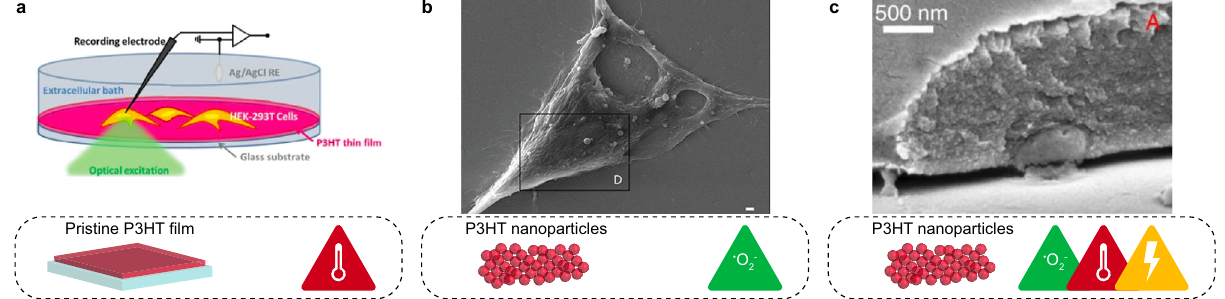
Fig. 3 Pure organic semiconductor bioelectronic interfaces. a The sketch shows a pristine P3HT layer interfaced with HEK-293 cells for the photothermal modulation of the membrane potential and other biological processes via the activation of TRPV1 channels. Image adapted under the Creative Commons Attribution (CC-BY) license 40 . b The scanning electron microscopy image shows P3HT NPs being internalised in a HEK-293 cell. Upon absorption of light, the internalised P3HT NPs modulated intracellular calcium dynamics via a photocatalytic process. Image adapted under the Creative Commons Attribution (CC-BY) license 14 . c The image shows an ultrastructural analysis of the interaction between a P3HT NP and a cultured primary neuron from a resin- embedded focused ion beam cross-section. NPs were not internalised but established a tight contact with the neuronal membrane. The injection of P3HT NPs in the subretinal space of blind rats endowed remaining retinal neurons with light sensitivity. The mechanism of interaction in-vivo is still unclear. Image reprinted by permission from Springer Nature 45 . In each panel, the dashed box shows a layer-by-layer sketch of the device and the putative main neuromodulation